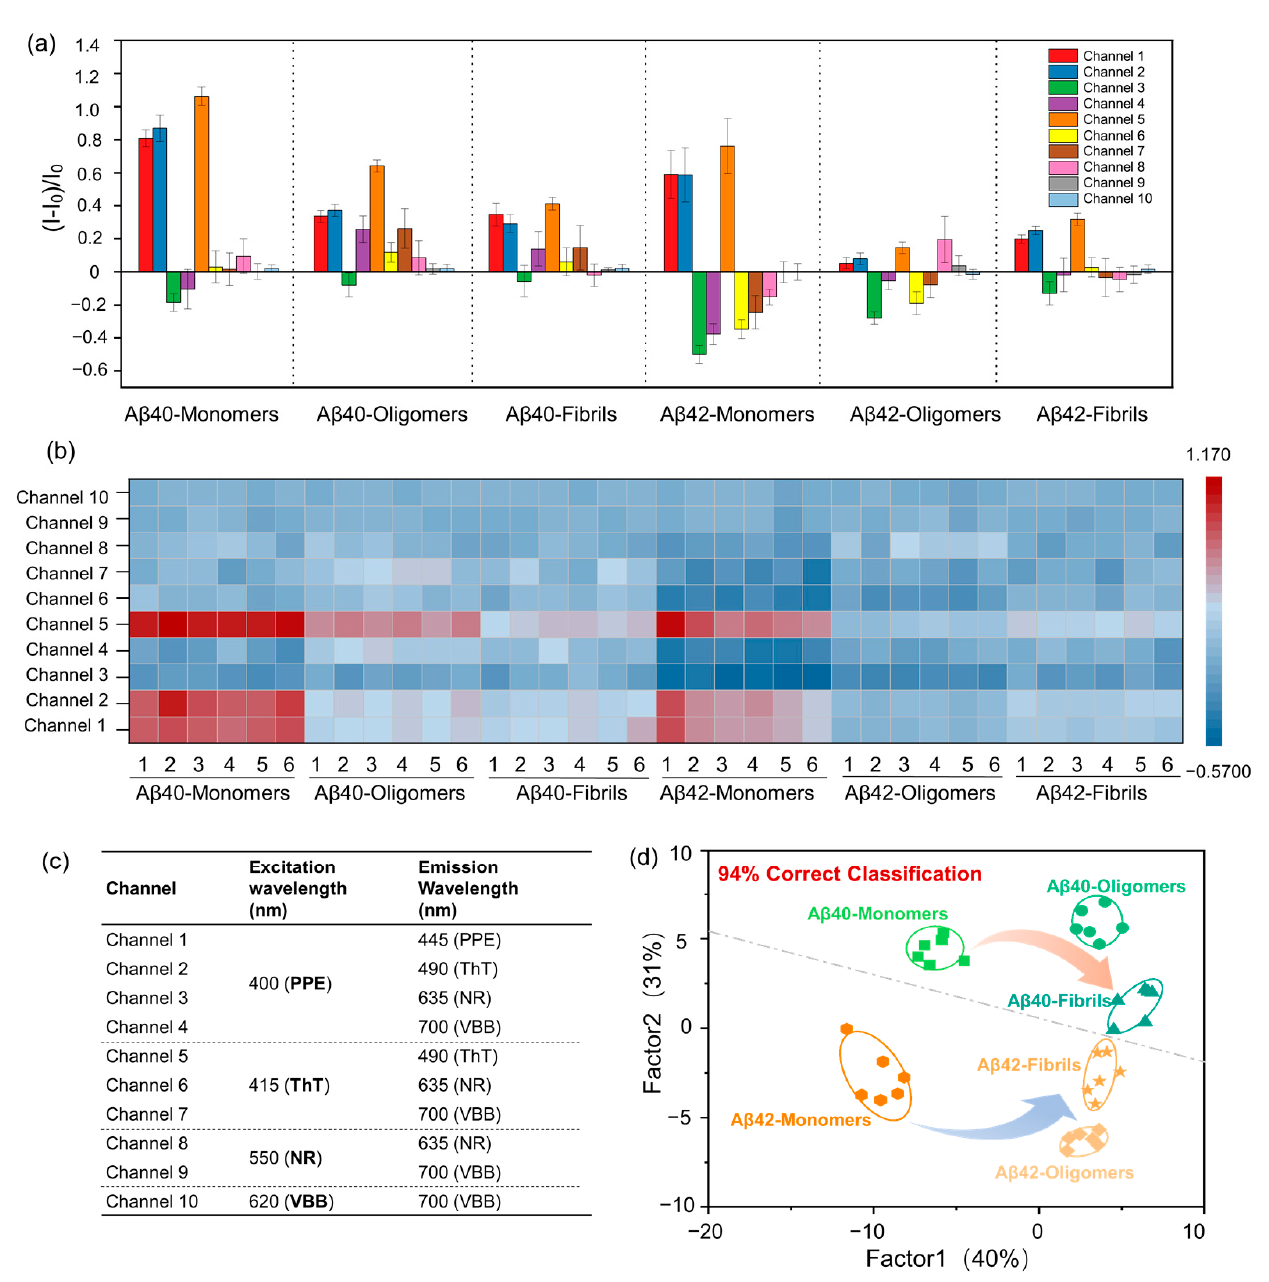
Figure 2. ( a ) Multichannel fluorescence response pattern (I − I 0 )/I 0 obtained by sensor array against A β 40/42 aggregates (1 µ M) in PBS, error bars indicate the standard deviation (SD) of six replicates. ( b ) Heat map of the fluorescence response of A β 40/42 aggregates in PBS. Six replicates are shown for each protein. ( c ) The excitation and emission wavelength of each channel. ( d ) Canonical score plot for the first two factors of fluorescence patterns obtained from the sensor array with A β 40/42 aggregates in PBS. The scores were generated through LDA with 95% confidence ellipses.